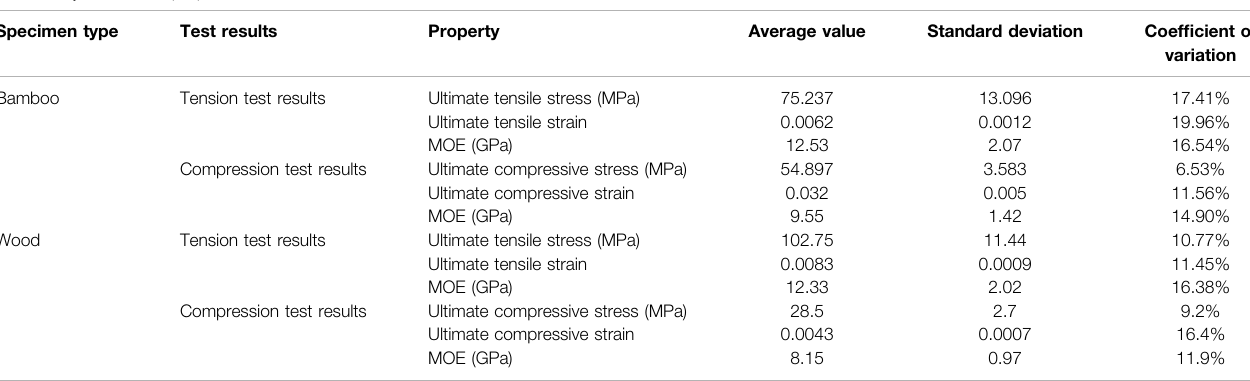
TABLE 1 | Mechanical properties of bamboo and